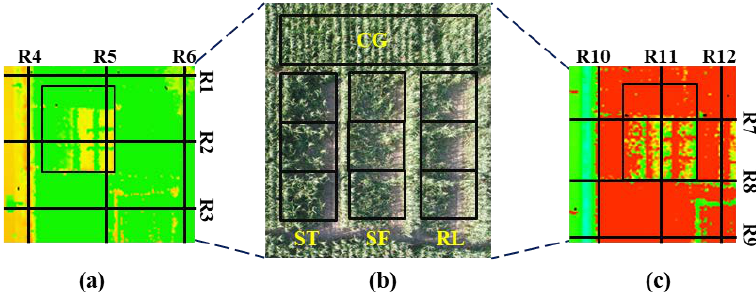
Figure 3. Description of the experimental design. ( a ) The experimental area and each flight route on August 28. ( b ) Experimental area. ( c ) The experimental area and each flight route on September 14.